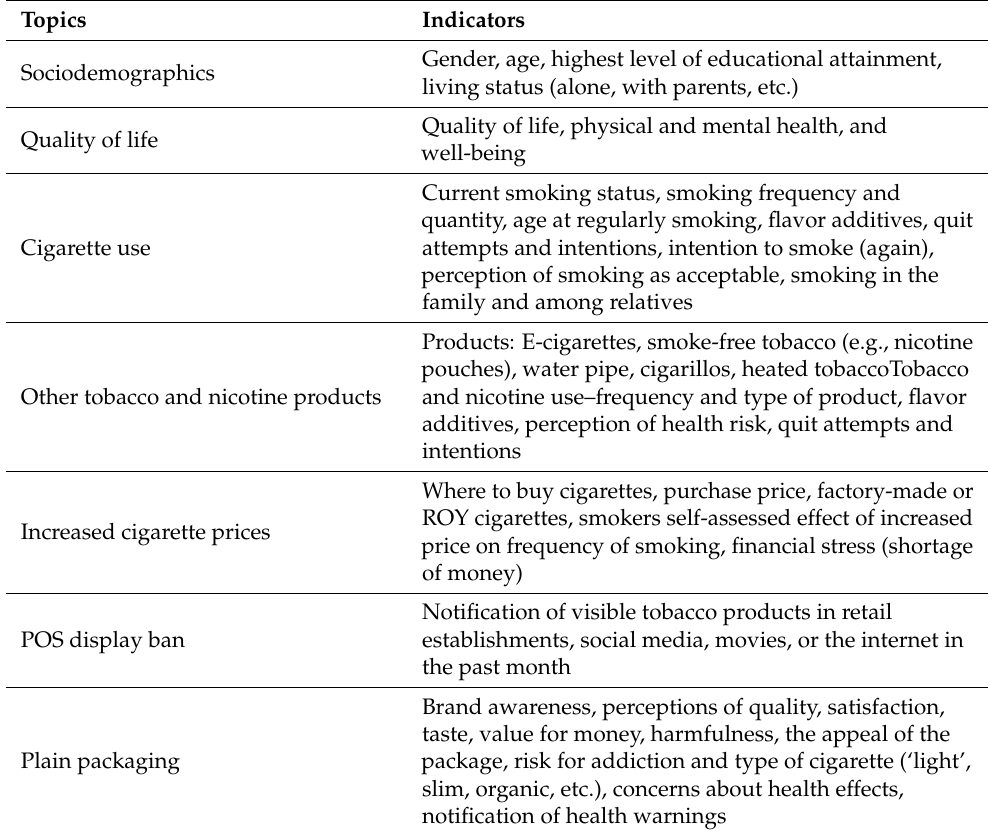
Table 2. Overview of the §SMOKE questionnaire and themes (baseline questionnaire).